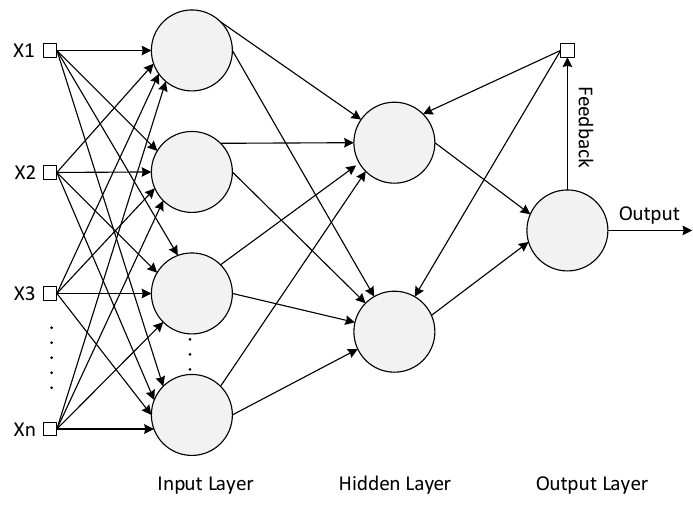
Figure 17. Illustration of recurrent neural network